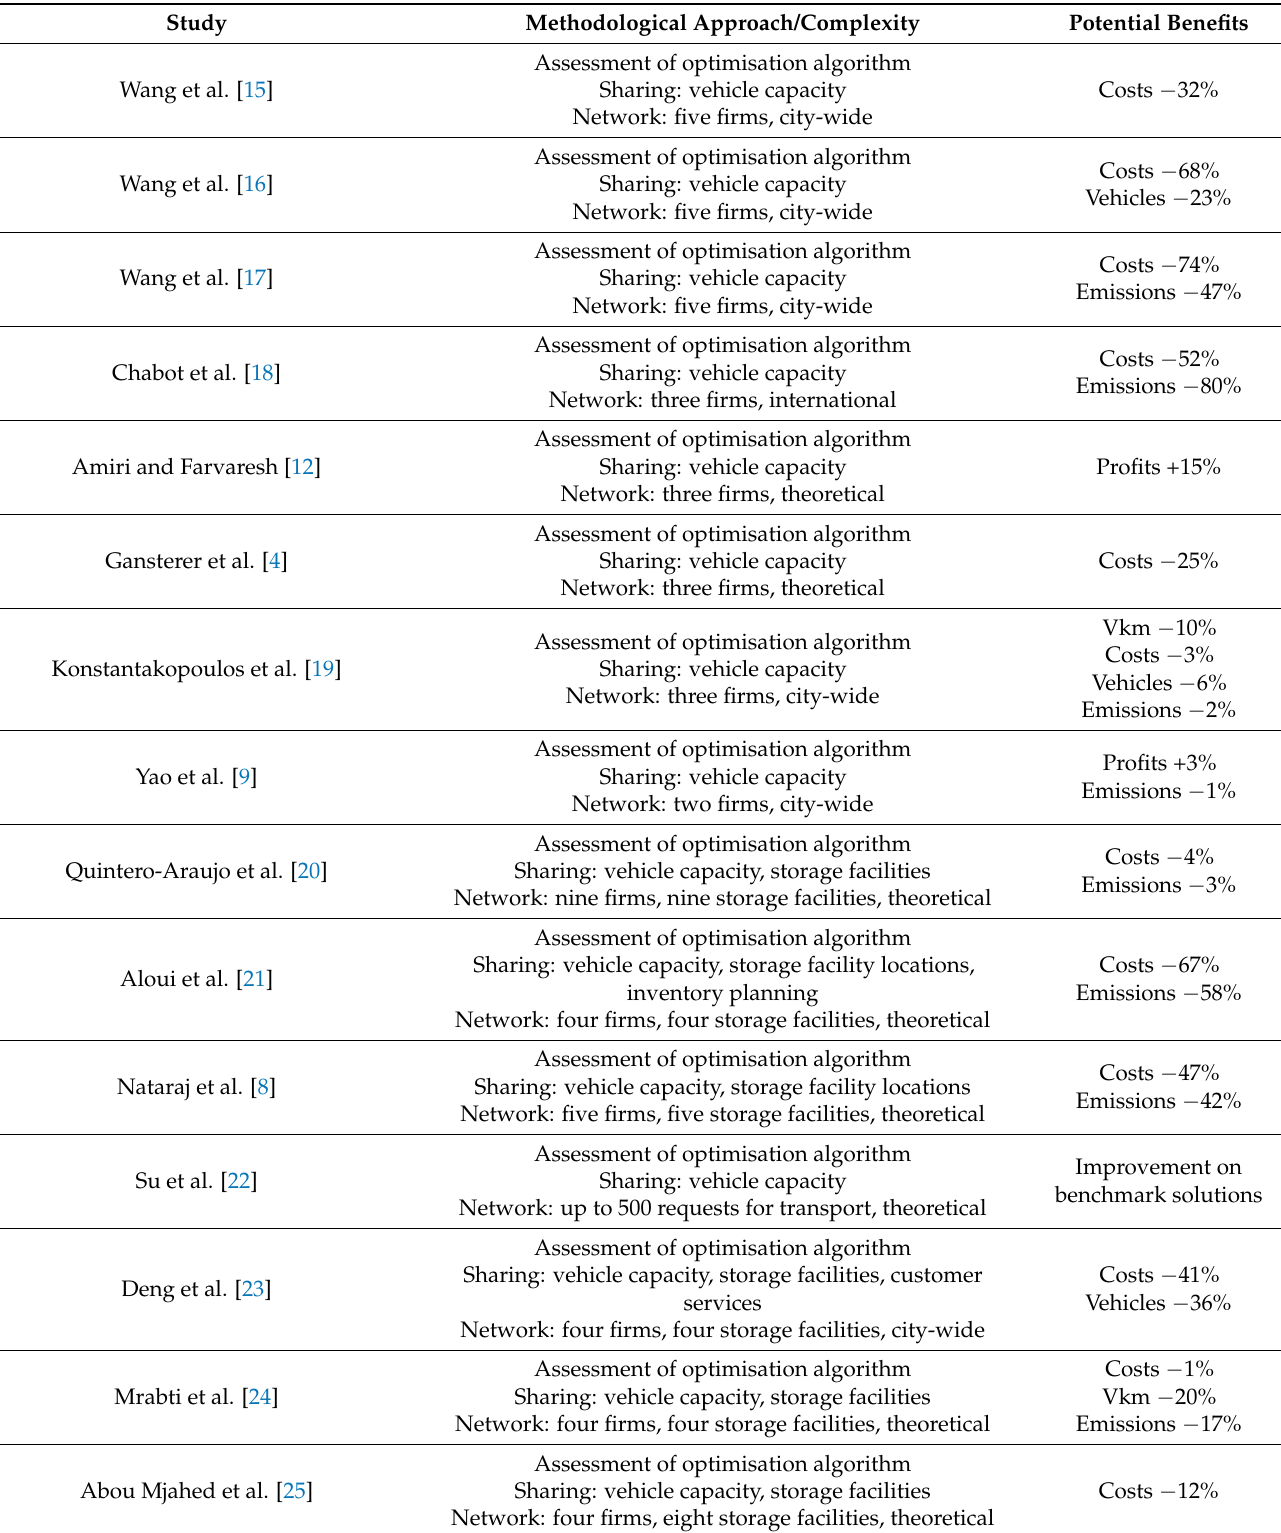
Table 1. Methodological approaches of previous studies of shared-fleet